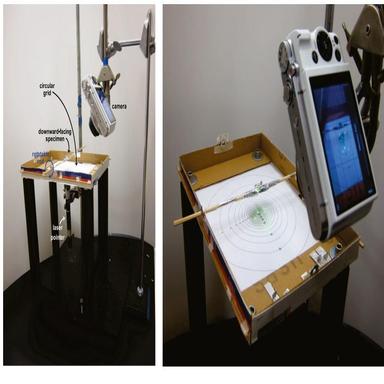
LBNL built a simple goniometer to compare retroreflection to specular reflection. Shown here: (a) side view of goniometer with laser pointer shining up and camera looking down; (b) top view of goniometer, showing a retroreflective specimen mounted on the turnable rod, central hole admitting laser beam, and concentric rings (5–75° in 5° increments) marking angle of specular reflection.